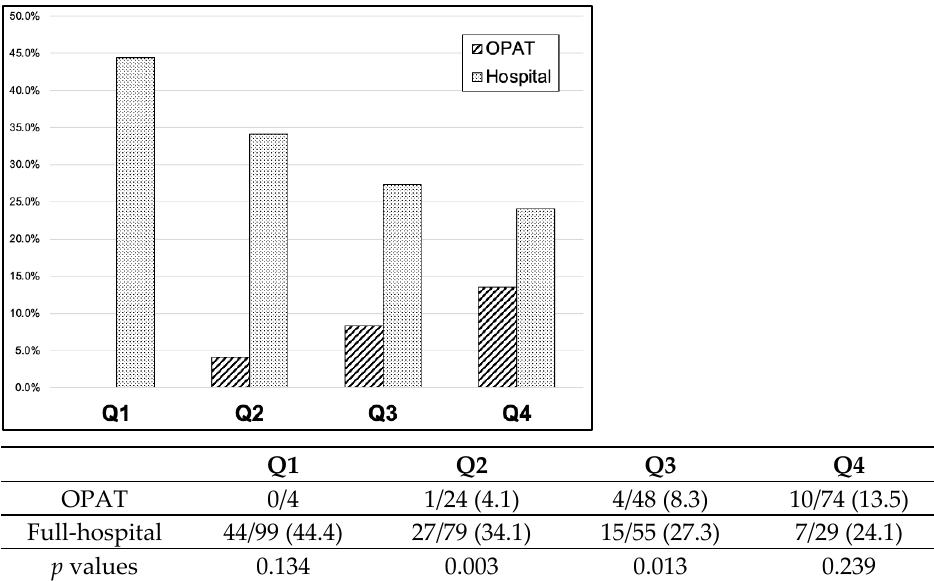
Figure 2. Sixty-day treatment failure stratified according to propensity score quartiles for being treated in the OPAT program (Q1, Q2, Q3, Q4). Data in the table are number of failures (death and/or relapse) / number of patients in each therapeutic modality group (percentage).